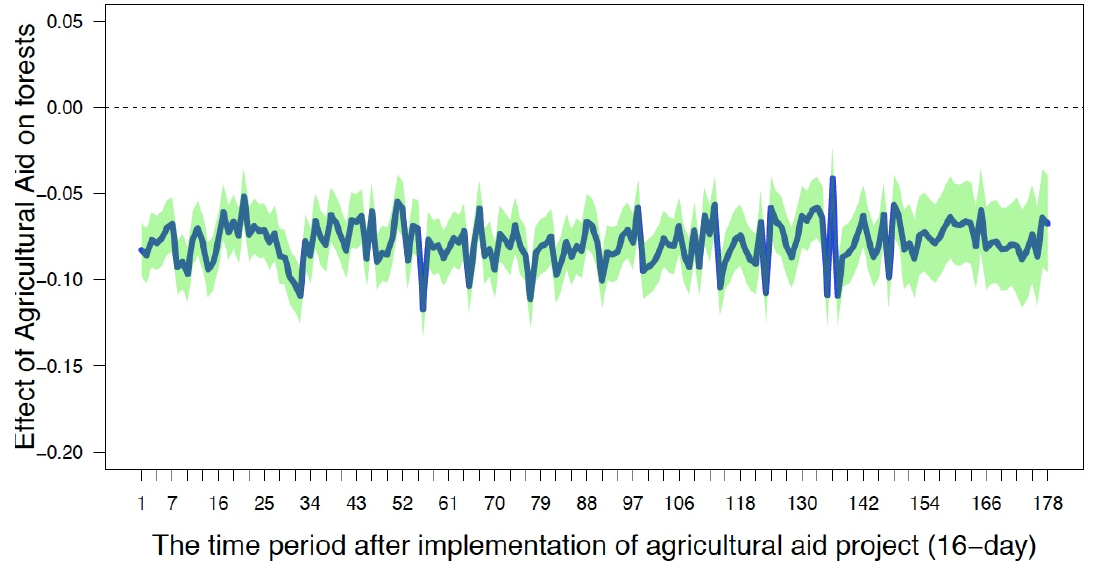
Figure A2. Causal effect of agricultural aid on sum forest NDVI across time with control variables of temperature and precipitation (the shaded green areas represent the 95% confidence interval). Table A2. Causal effect of agricultural aid on sum forest NDVI by types of agricultural aid with the control variables of temperature and precipitation.